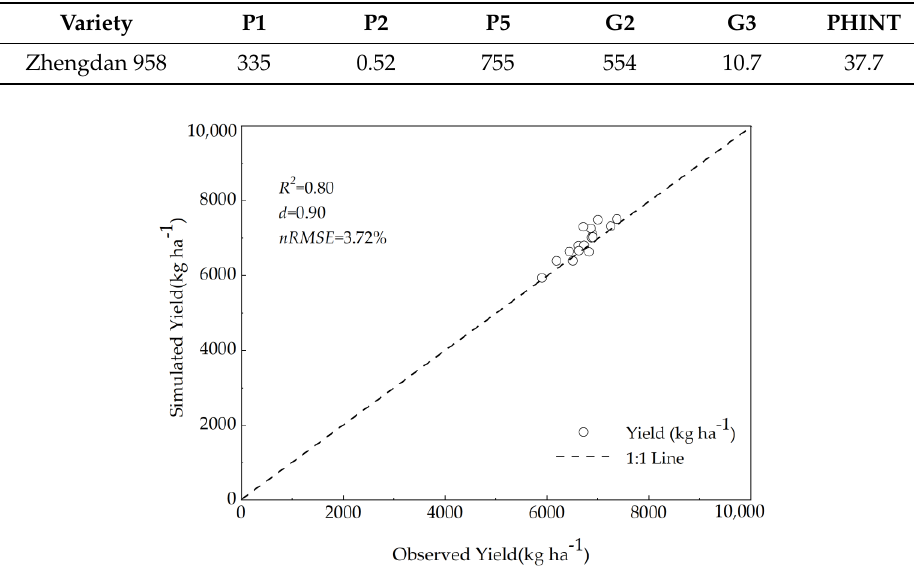
Table 4. Final crop parameters for Zhengdan 958 summer maize.